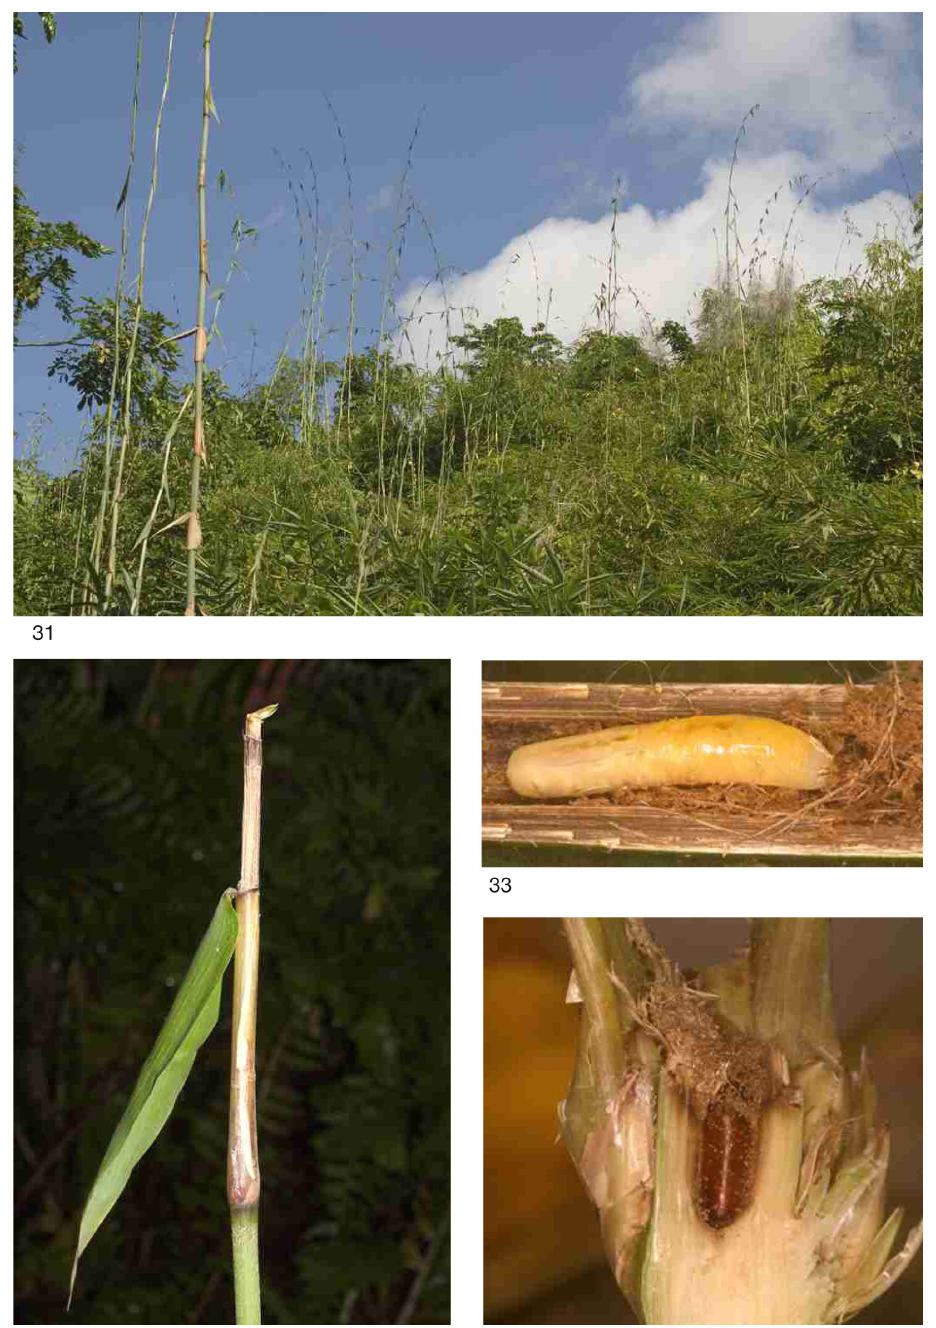
Figs 31–34. Ichneumonopsis burmensis Hardy, 1973, biological traits. 31 . Bamboo shoots of the host plant, Pseudoxytenanthera albociliata , at the edge of an abandoned field in northern Thailand in November. The shoots are 2–5 m tall and up to 2 cm wide at the base. 32 . Bamboo internode (ca 7 mm wide) infested by an I. burmensis larva. The internode is located at the tip of the bamboo shoot, because the apical 4–5 internodes have died and fallen to the ground. 33 . A fully-grown I. burmensis larva (length ca 14 mm) that has started to bite off strips of vascular bundles from the bamboo shoot wall (on the right) in order to create a cocoon. 34 . I. burmensis puparium (length ca 8 mm) located in the internode cavity at the base of the infested internode. The upper part of the internode has broken off. Side branches growing from the basal bud were partly